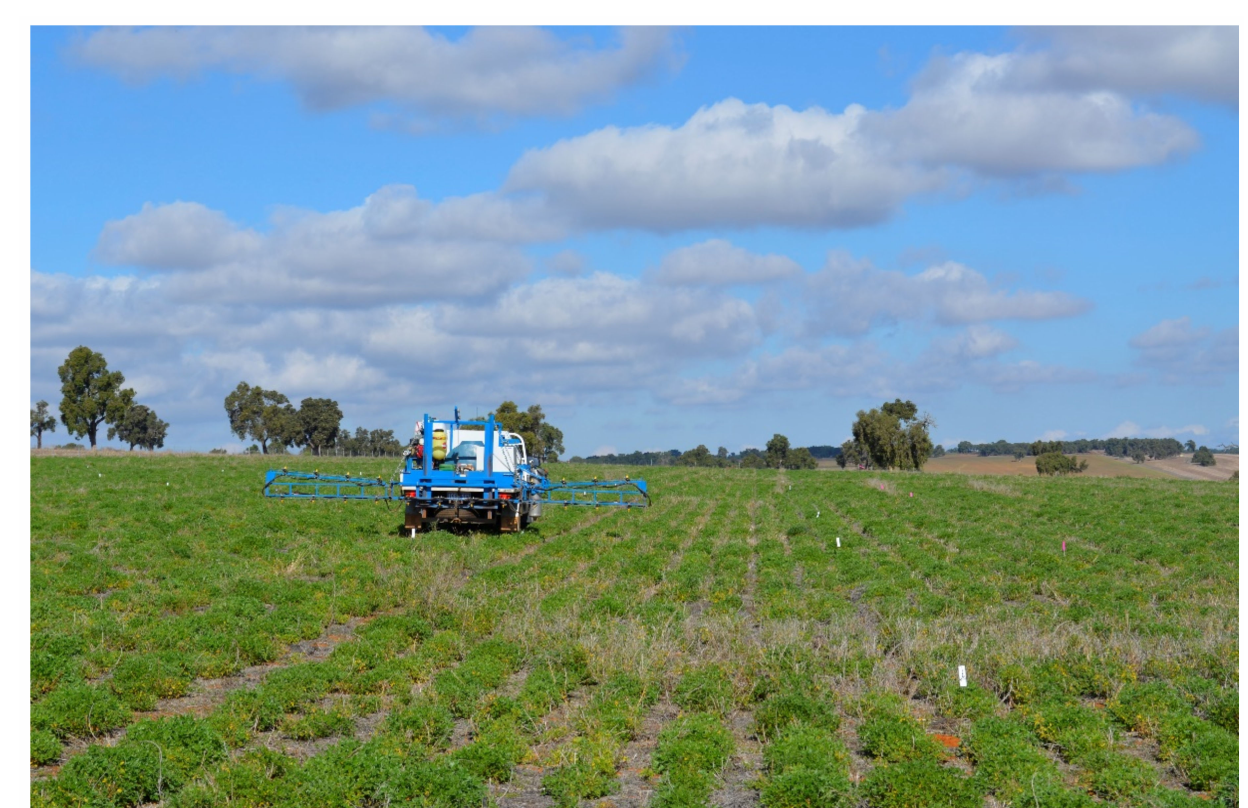
Figure 1. Spraying a two-year-old stand of tedera with 15 post-emergent herbicide experiment at Dandaragan on 15 June